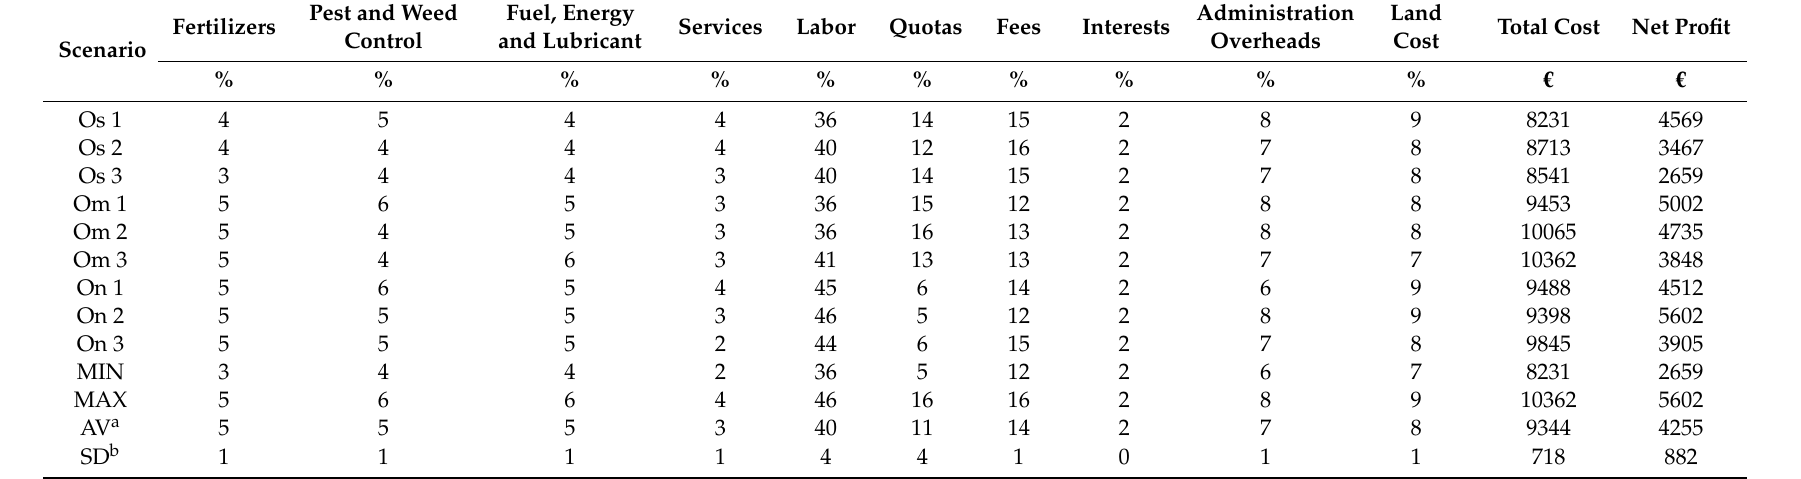
Table 6. Economic results for the organic farming system (ha − 1 year − 1